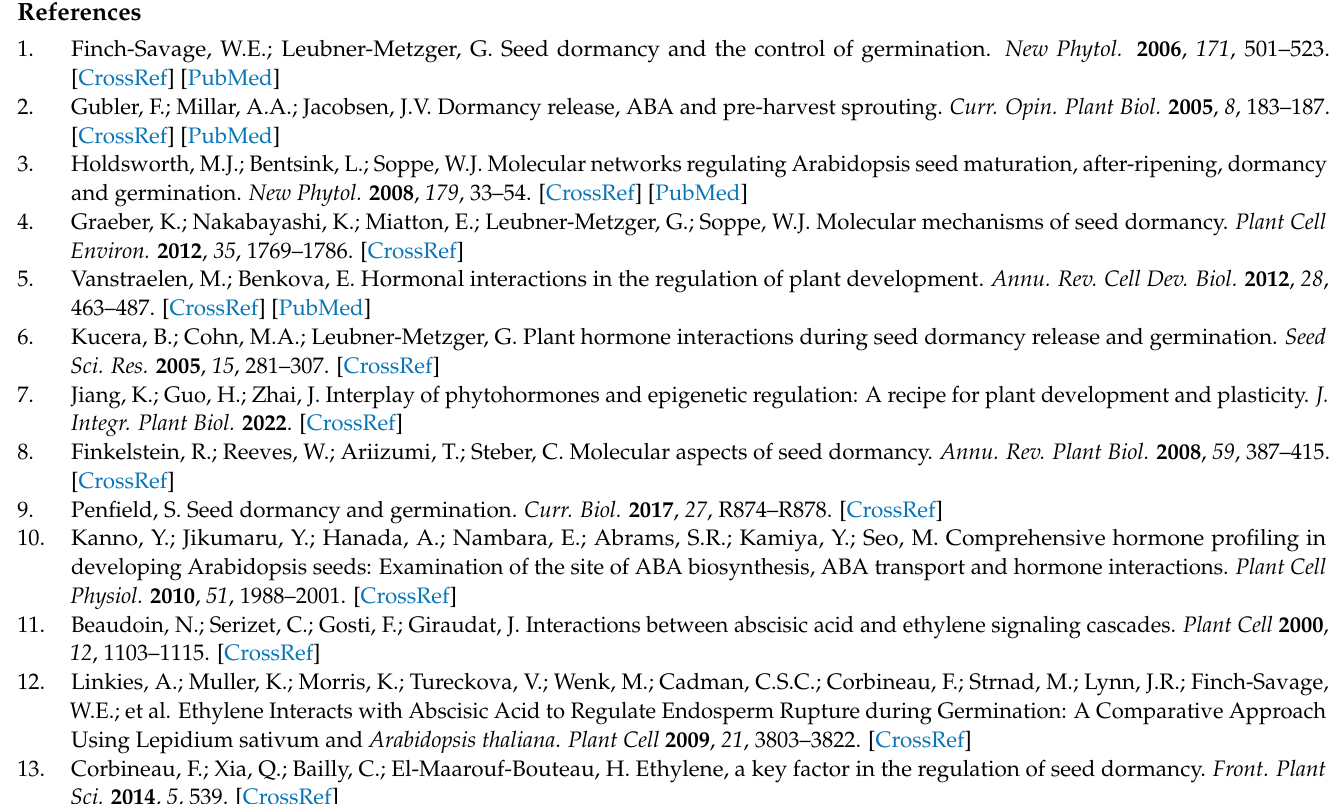
Figure S3: Validation of the expression of marker genes by RT-qPCR assays. Table S1. All DEGs list in dry seeds and imbibition seeds. Table S2. The Hormone-related genes list. Table S3. Primers used for